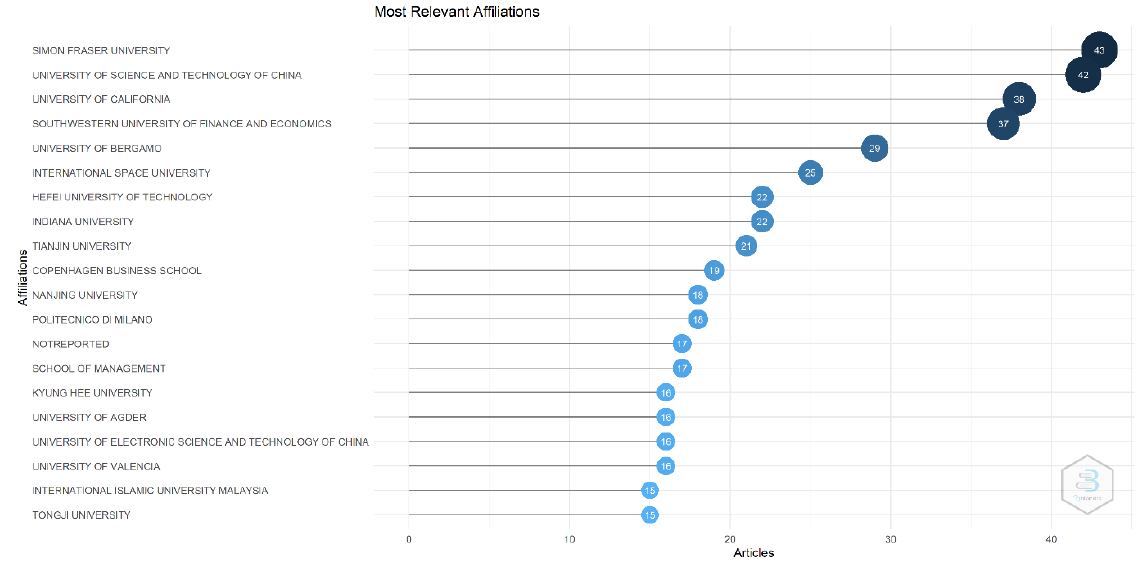
Figure 7. Most influential